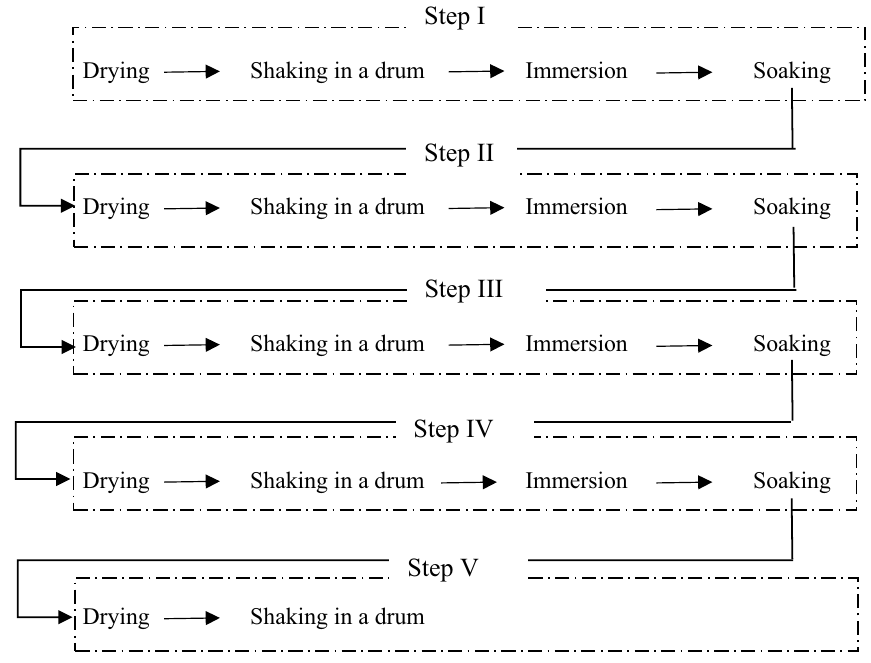
Figure 1. Scheme of the seed extraction process: ( a ) drying; ( b ) shaking in a drum; ( c ) immersion; ( d )